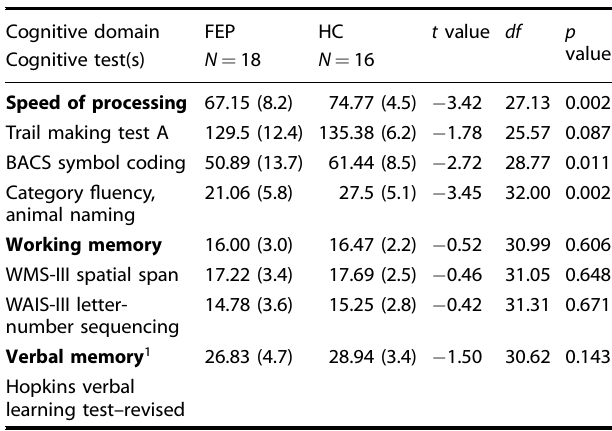
Table 2. Raw scores of MCCB cognitive domains ( in bold ) and their respective cognitive tests, mean (standard